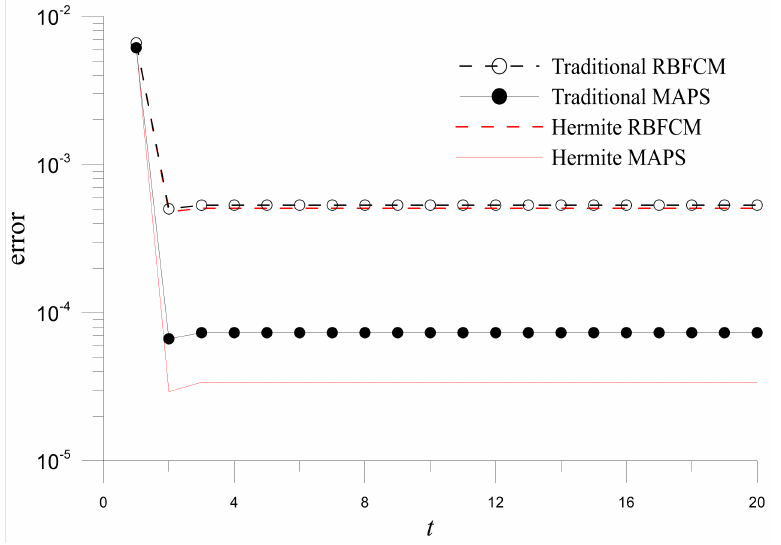
Figure 15. Time histograms of errors for numerical solutions obtained by the four methods in Example